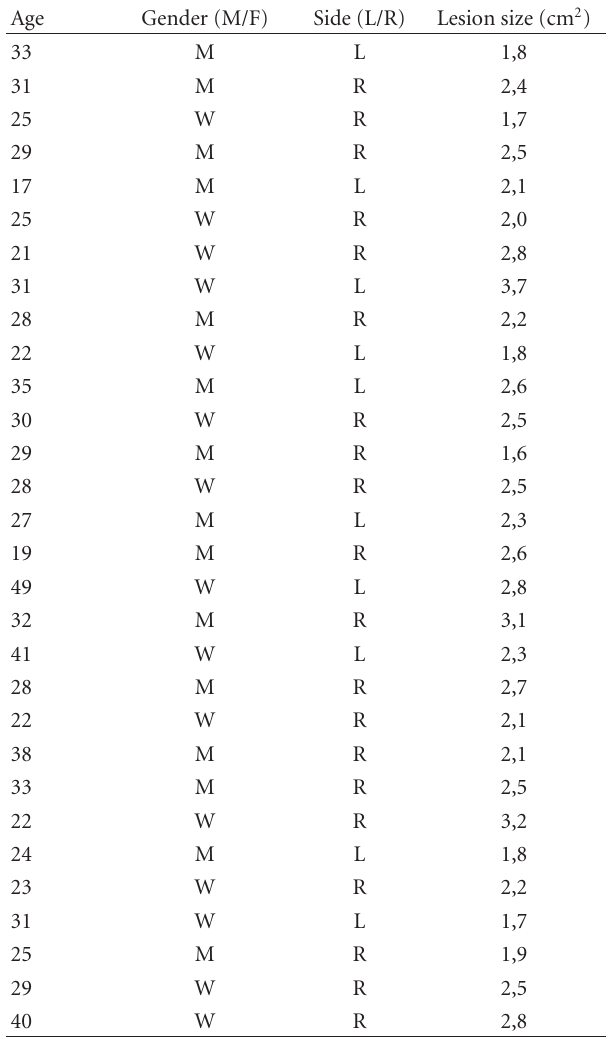
Table 1: Patient’s data: age, gender, side, and size of